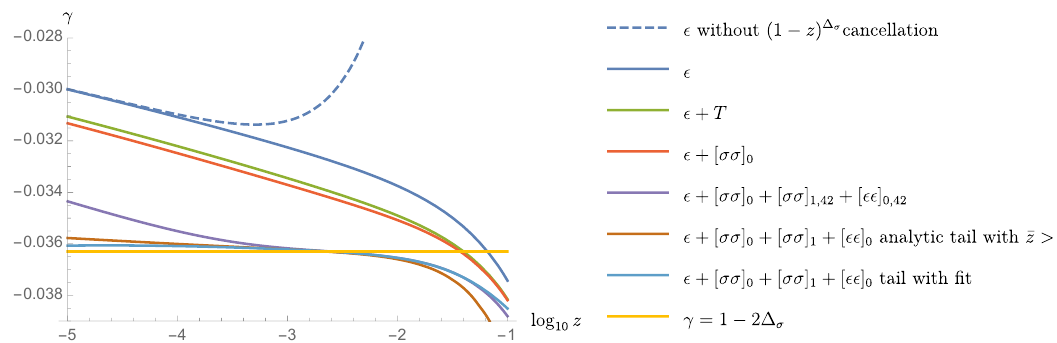
Figure 3 . The effect of different t -channel truncations in eq. (2.21) on the extracted stress-tensor anomalous dimension γ T = τ T − 2∆ φ . Including more operators enables us to reach lower values of z where we find a stable z -independent